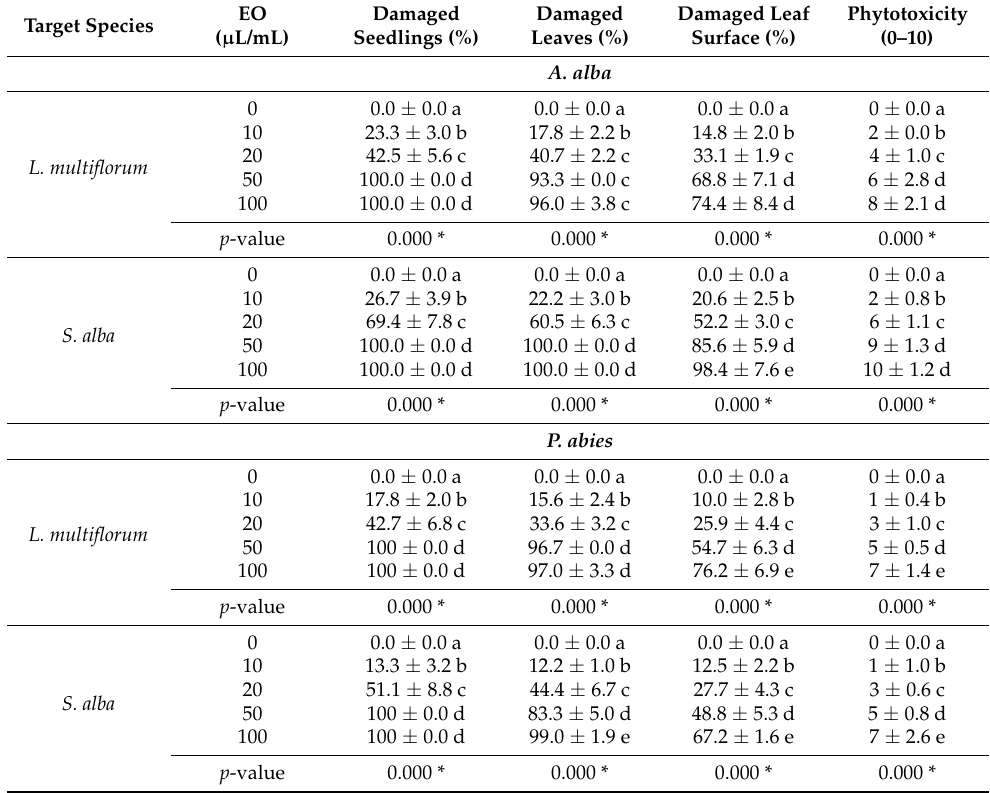
Table 5. Phytotoxic effects of different concentrations of EOs (liquid phase) on two target species in post-emergence